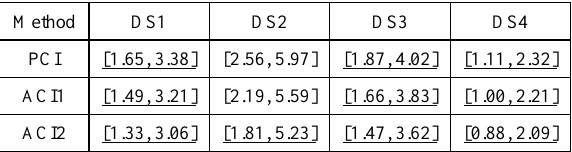
Table 6. The estimation results of model parameter 𝜅 with BS1